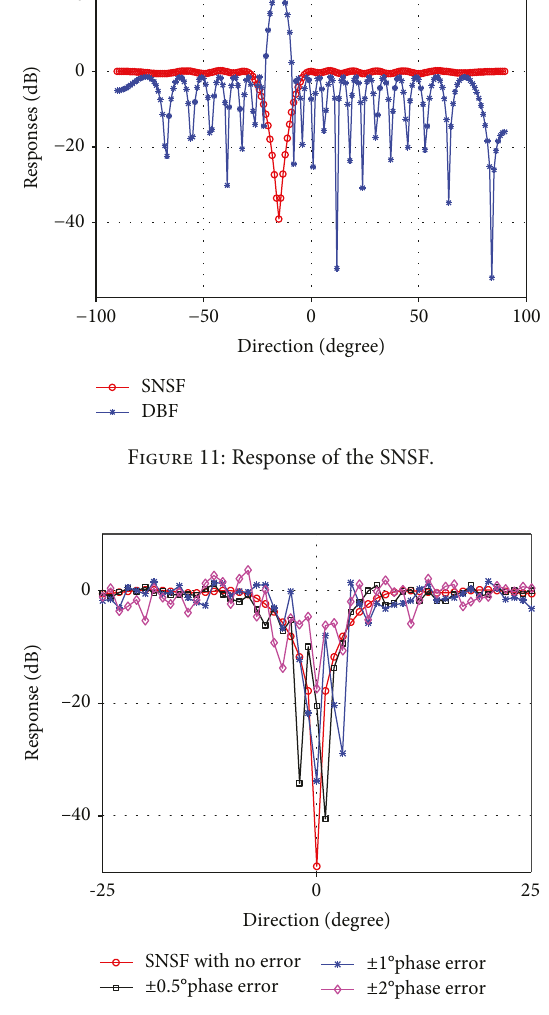
Figure 12: Response of SNSF with phase